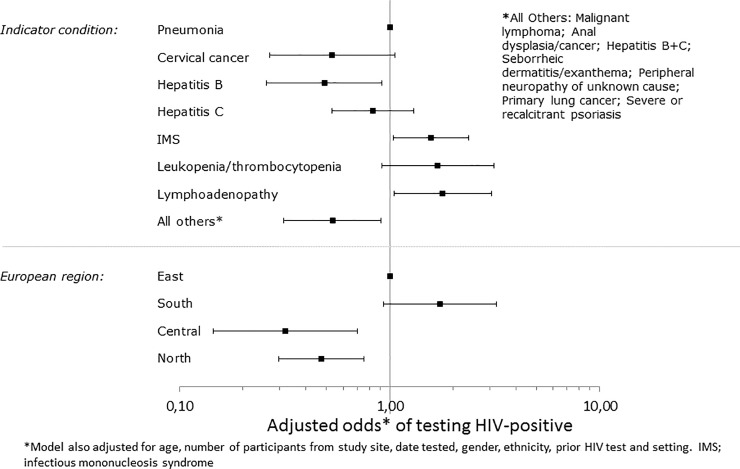
Adjusted odds of testing HIV positive.